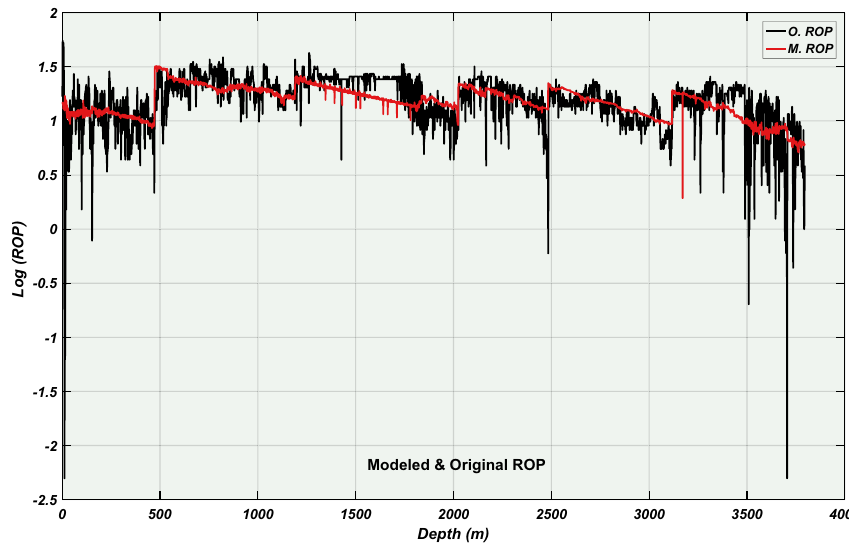
Fig. 8 Modeled and original ROP for